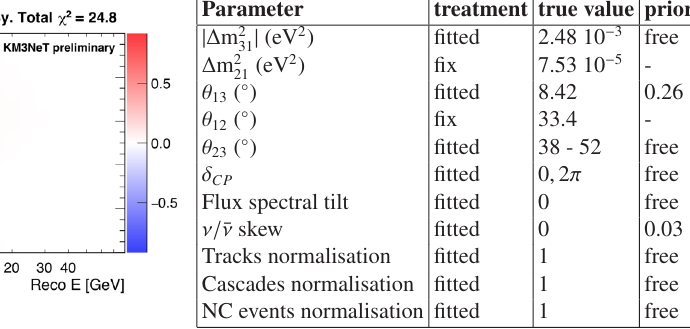
Figure 1 . Signed χ 2 shown as a function of reconstructed neutrino energy and co-sine zenith for shower-like events. Figure in Ref. [2]